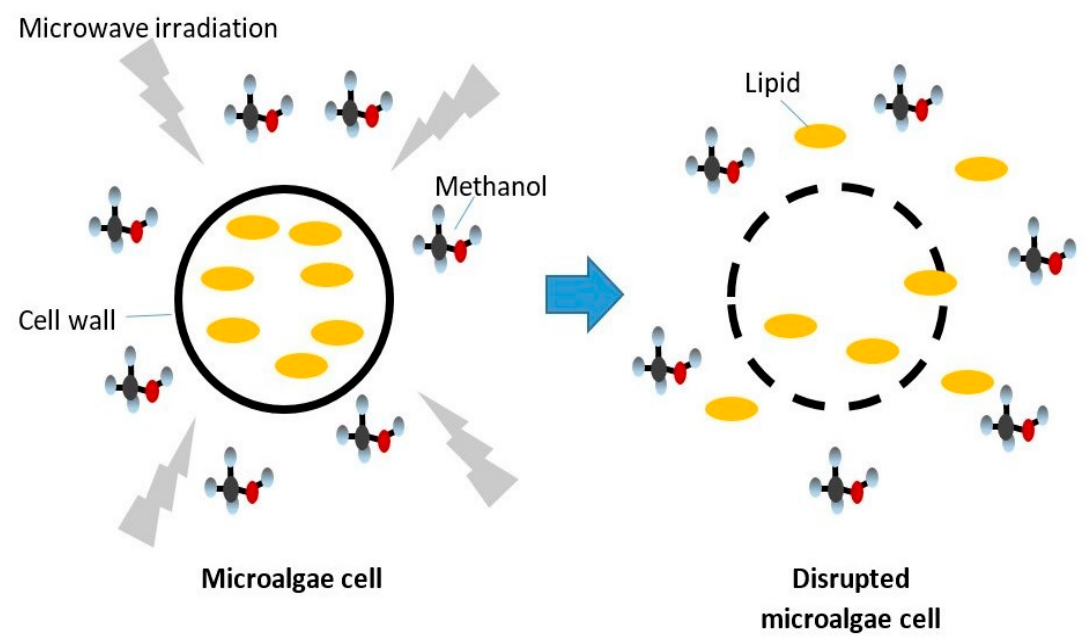
Figure 7. Microalgae cell disruption under microwave irradiation [81,132] .